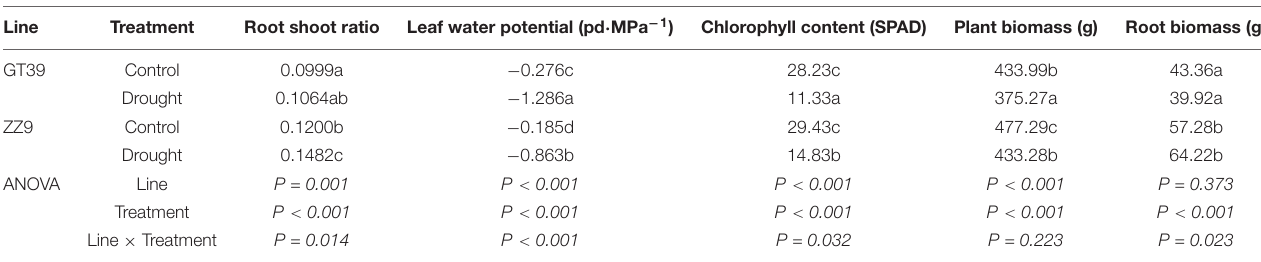
TABLE 2 | Plant traits of different varieties under different water